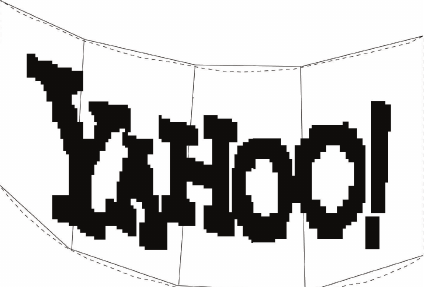
Figure 8: A harmonic distorted image is approximated by piecewise bilinear